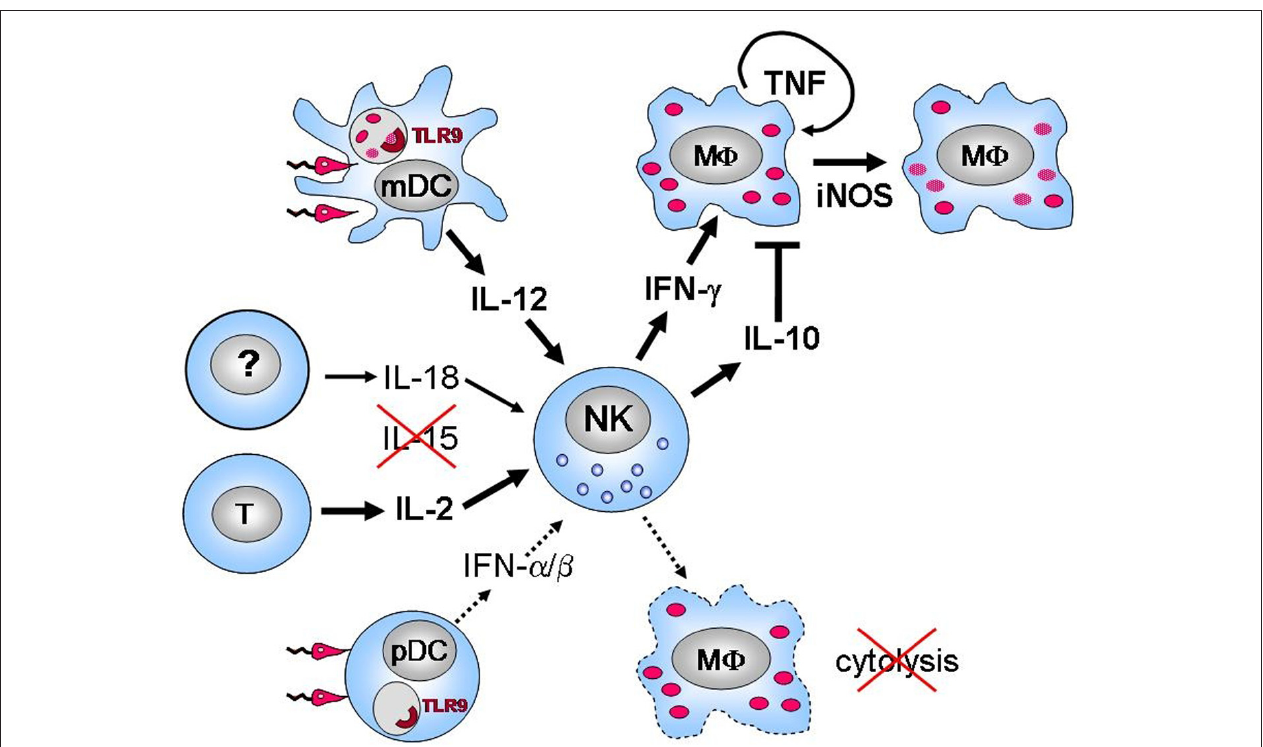
FIGURE 1 | Current of view of the activation and function of NK cells in experimental visceral leishmaniasis (i.v. infection of mice with L. infantum or L. donovani ). Leishmania promastigotes are endocytosed by CD11c + myeloid DC, which subsequently produce the NK cell-activating cytokine IL-12 in a TLR 9-dependent manner (Schleicher et al., 2007). In addition to IL-12 the cytokine IL-2 (in analogy to previous findings in mouse L. major infections (Scharton and Scott, 1993; Bihl et al., 2010) presumably derived from CD4 + T lymphocytes) is also